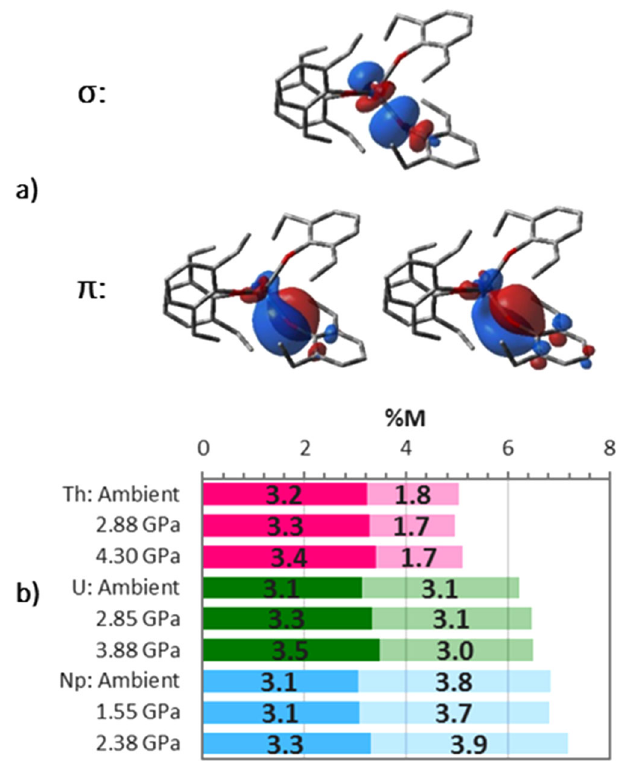
Fig. 8 | ThenatureofM-ObondinginM(OAr) 4 . a The σ - and π -typeM-O bonding NLMOs for Np(OAr) 4 at ambient pressure. The NLMOs for the other systems are similar. b Themetalcontribution(%M),averagedfrom σ andtwo π ,areshownwith relative contributions from d (dark), and f (light) orbitals depicted. There is no signi fi cants-orp-orbital(<2and<0.1%respectively)contribution.Therawdatafor this fi gure are available in Supplementary Table